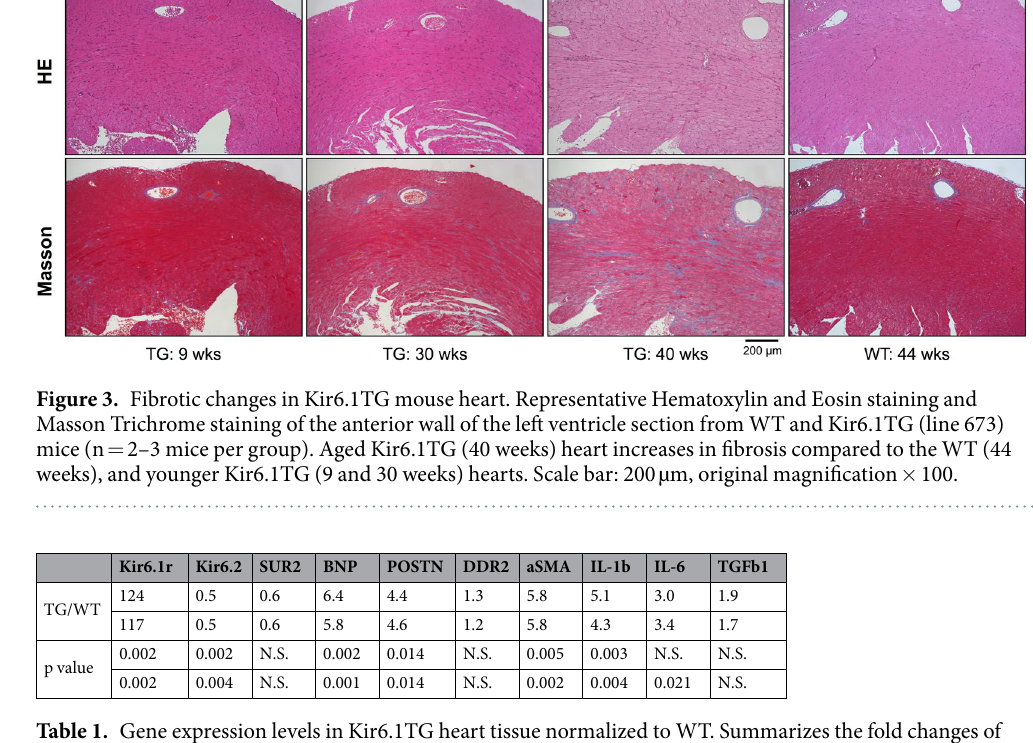
Table 1. Gene expression levels in Kir6.1TG heart tissue normalized to WT. Summarizes the fold changes of Kir6.1TG (includes all ages, upper row: n = 8 (line 673), lower row: n = 11 including line 111 with line 673)